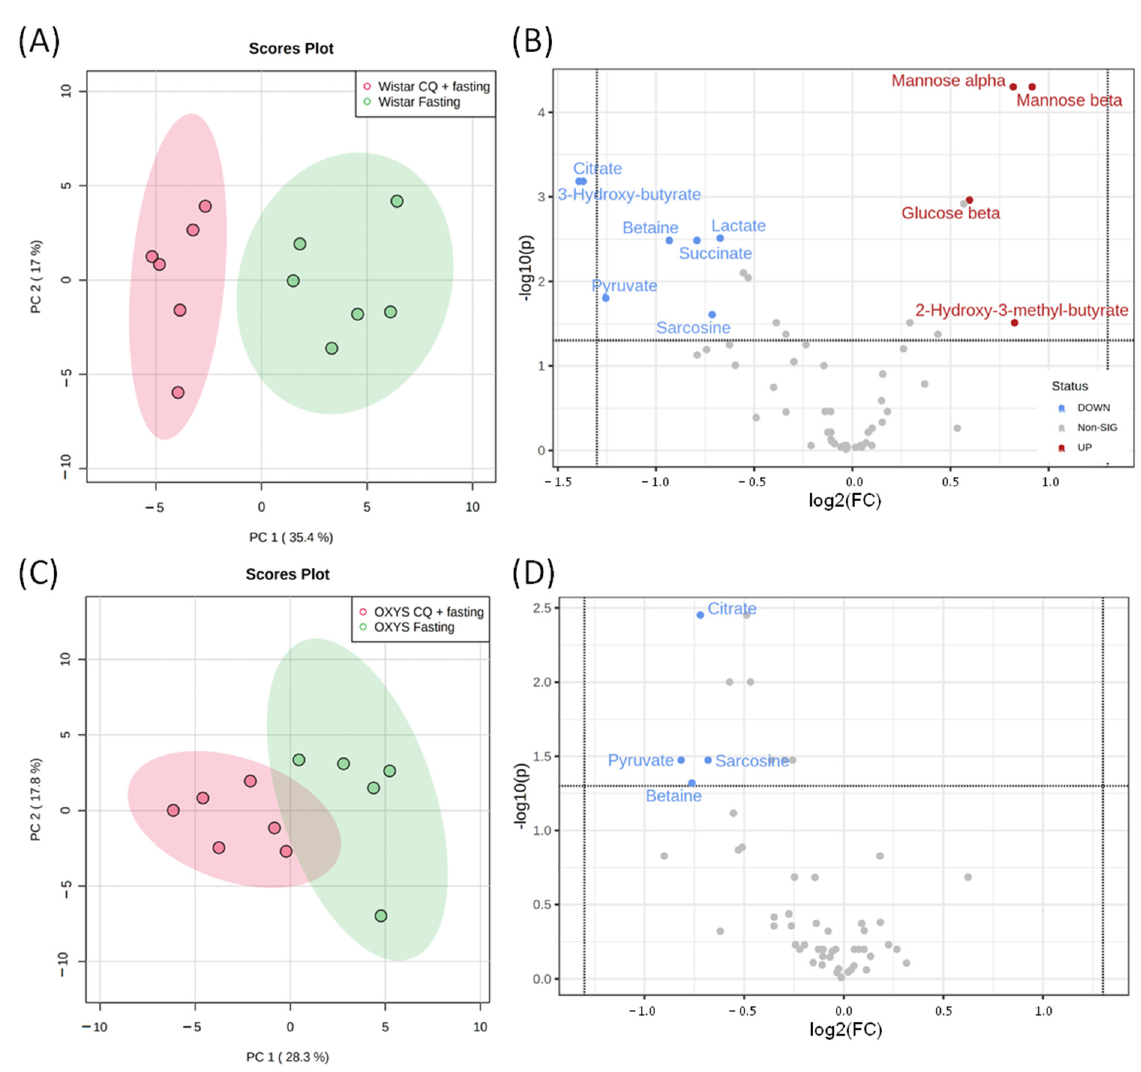
Figure 7. The metabolomic profiles of fasting groups with and without CQ treatment. PCA score plots and Volcano plots of blood metabolites of Wistar ( A , B ) and OXYS ( C , D ) rat strains. In Volcano plots horizontal line depicts a cut-off of FDR-adjusted p -value = 0.05, metabolites with fold change threshold (CQ treatment vs. fasting) = 1.5 are highlighted.